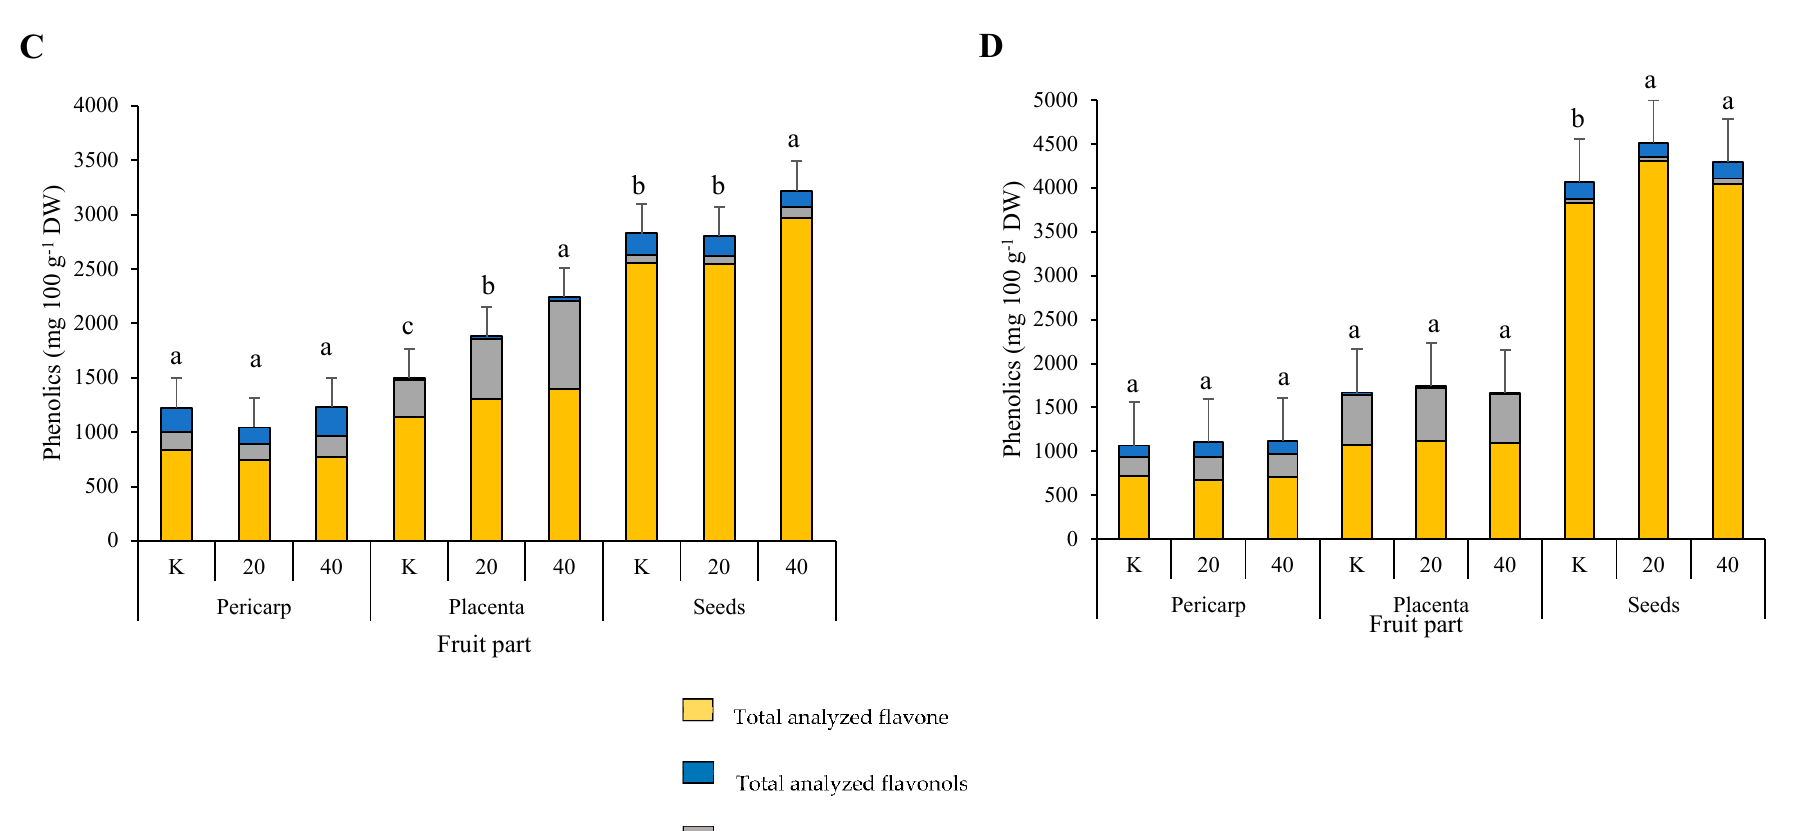
Figure 1. Total phenolics contents in four salt stressed pepper ( Capsicum annuum L.) cultivars (‘Caro F1’ ( A ); ‘Somborka’ ( B ); ‘Novosadka’ ( C ); ‘Berenyi F1’ ( D )) divided into three fruit parts. a, b, c indicates statistical differences among the NaCl treatments and the control. K = control; 20 = 20 mM NaCl; 40 = 40 mM NaCl.